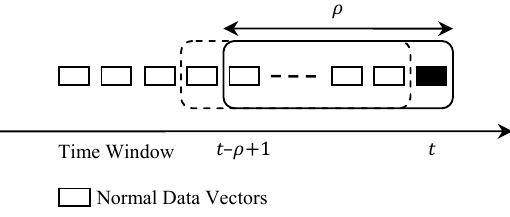
Figure 1. The projection distance of a data vector (cid:2206) (cid:2193)(cid:2191) from the global first principal component (cid:2256) .